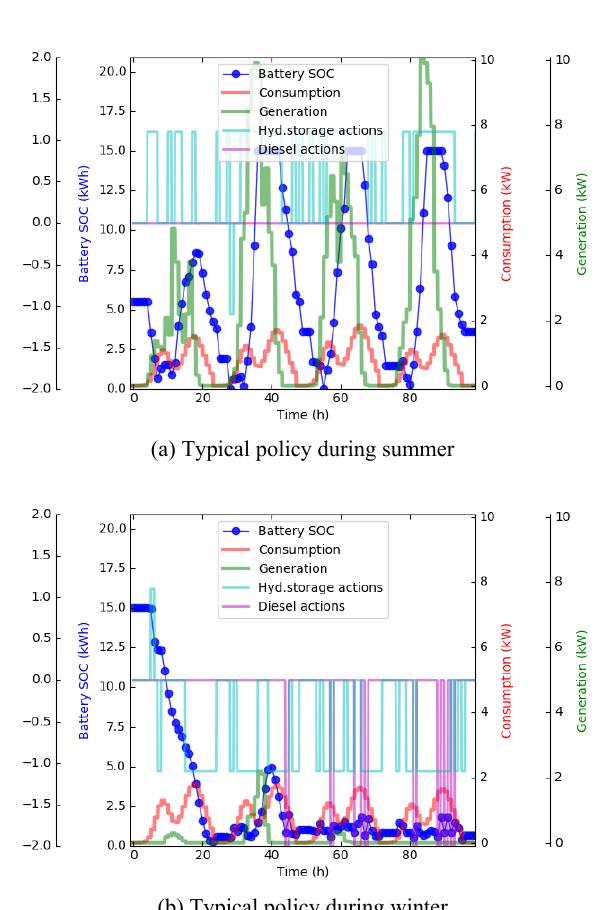
Fig. 17. Computed policy with extended information available to the agent. DG action/H action = 0 means keeping it idle or to do nothing; DG action = -2 means turning ON at full capacity; DG action = -1 means turning ON at 75% capacity; H action = - 1 means discharging the hydrogen storage; H action = 1 means charging the hydrogen storage